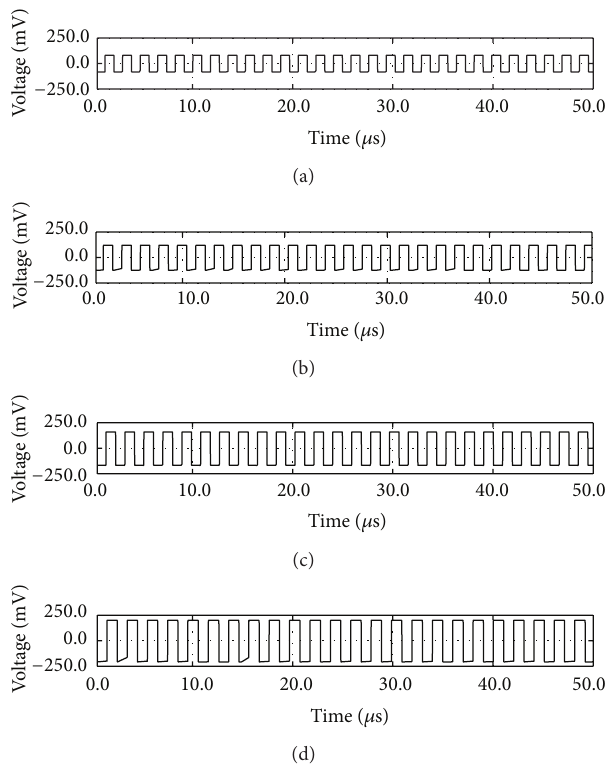
Figure 14: Output voltage with (a) 𝐼 𝐼 = 30 𝜇 A, (c) 𝐼 Bias 2